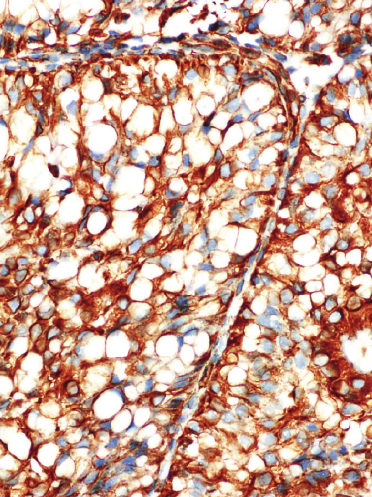
Figure 3: Hyperplastic endometrial gland structures and tumour cells with signet-ring cell morphology; H&E × 440.